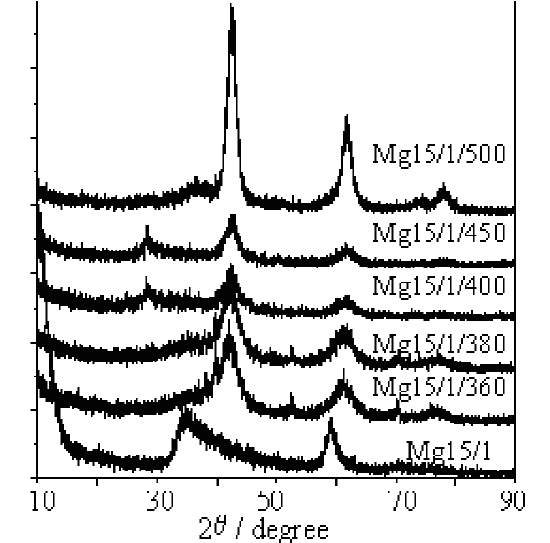
Fig. 2 XRD spectra sample Mg15 /1 and samples Mg15/1/360 -